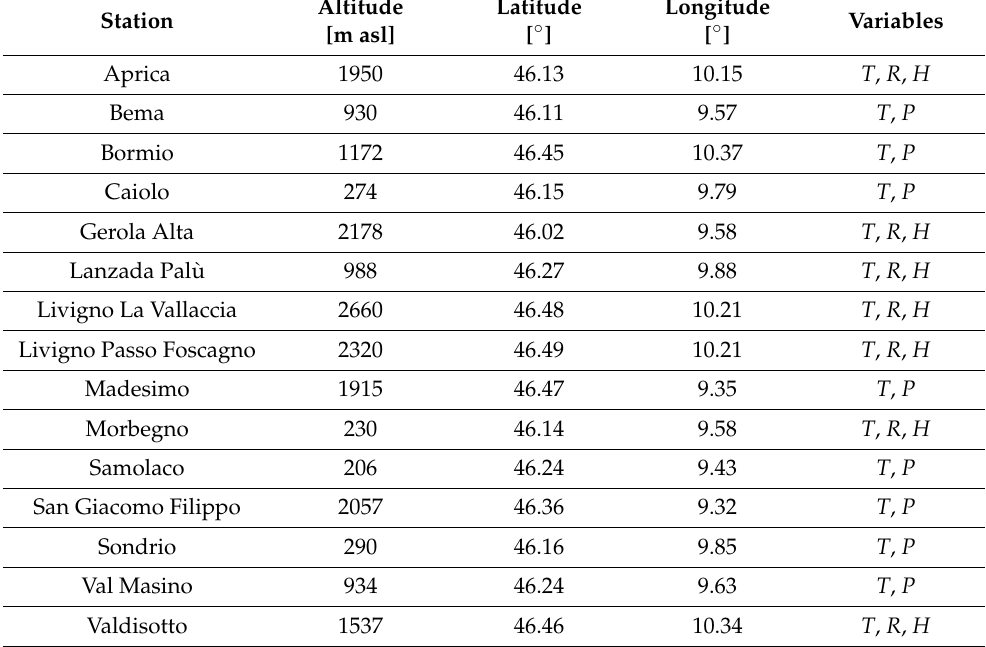
Table 1. Meteorological stations considered for the model: elevation, position, and measured vari- ables. T is temperature, P is total precipitation (heated rain gauge), R is (liquid) rainfall, H is snow depth. The location of the stations is visible in Figure 1.